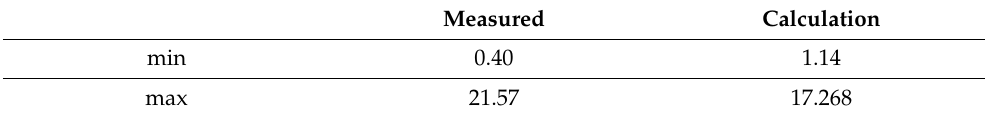
Table 20. Minimum and maximum value of measured and calculated value. Measured Calculation min 0.40 1.14 max 21.57 17.268 Final equation is (7). Calculated values of deposition of chloride ions for individual months are quantified in the Table 21. A graphical representation of the measured and calculated values is shown in Figure 7.